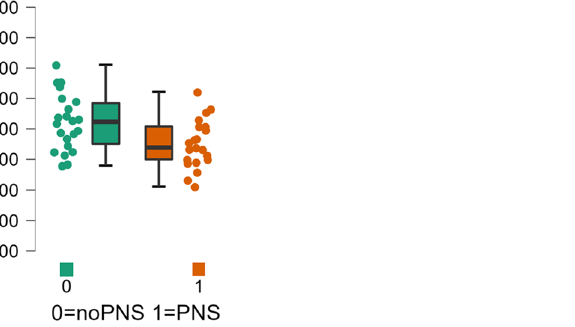
Figure 1. Group differences of cortical thickness. Plots showing a lower volume of the bilateral pericalcarine cortex in the PNS subgroup compared to the noPNS subgroup. Volume is measured in mm 3